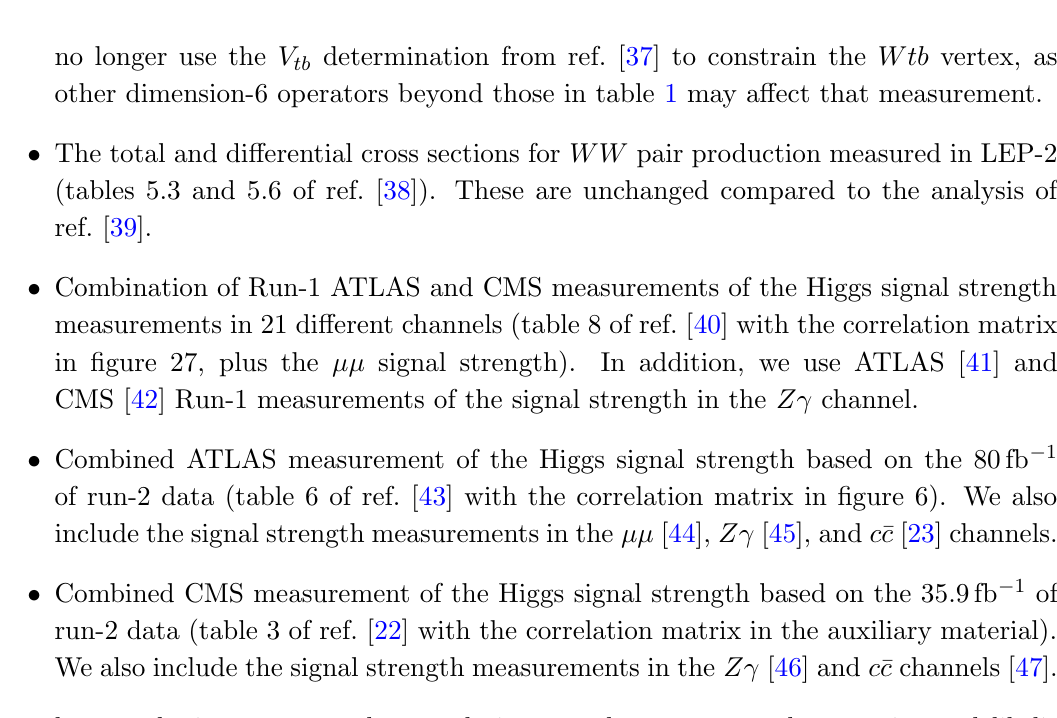
Table 1 . Dimension-6 SMEFT operators in the Warsaw basis relevant for the Higgs and electroweak observables at tree